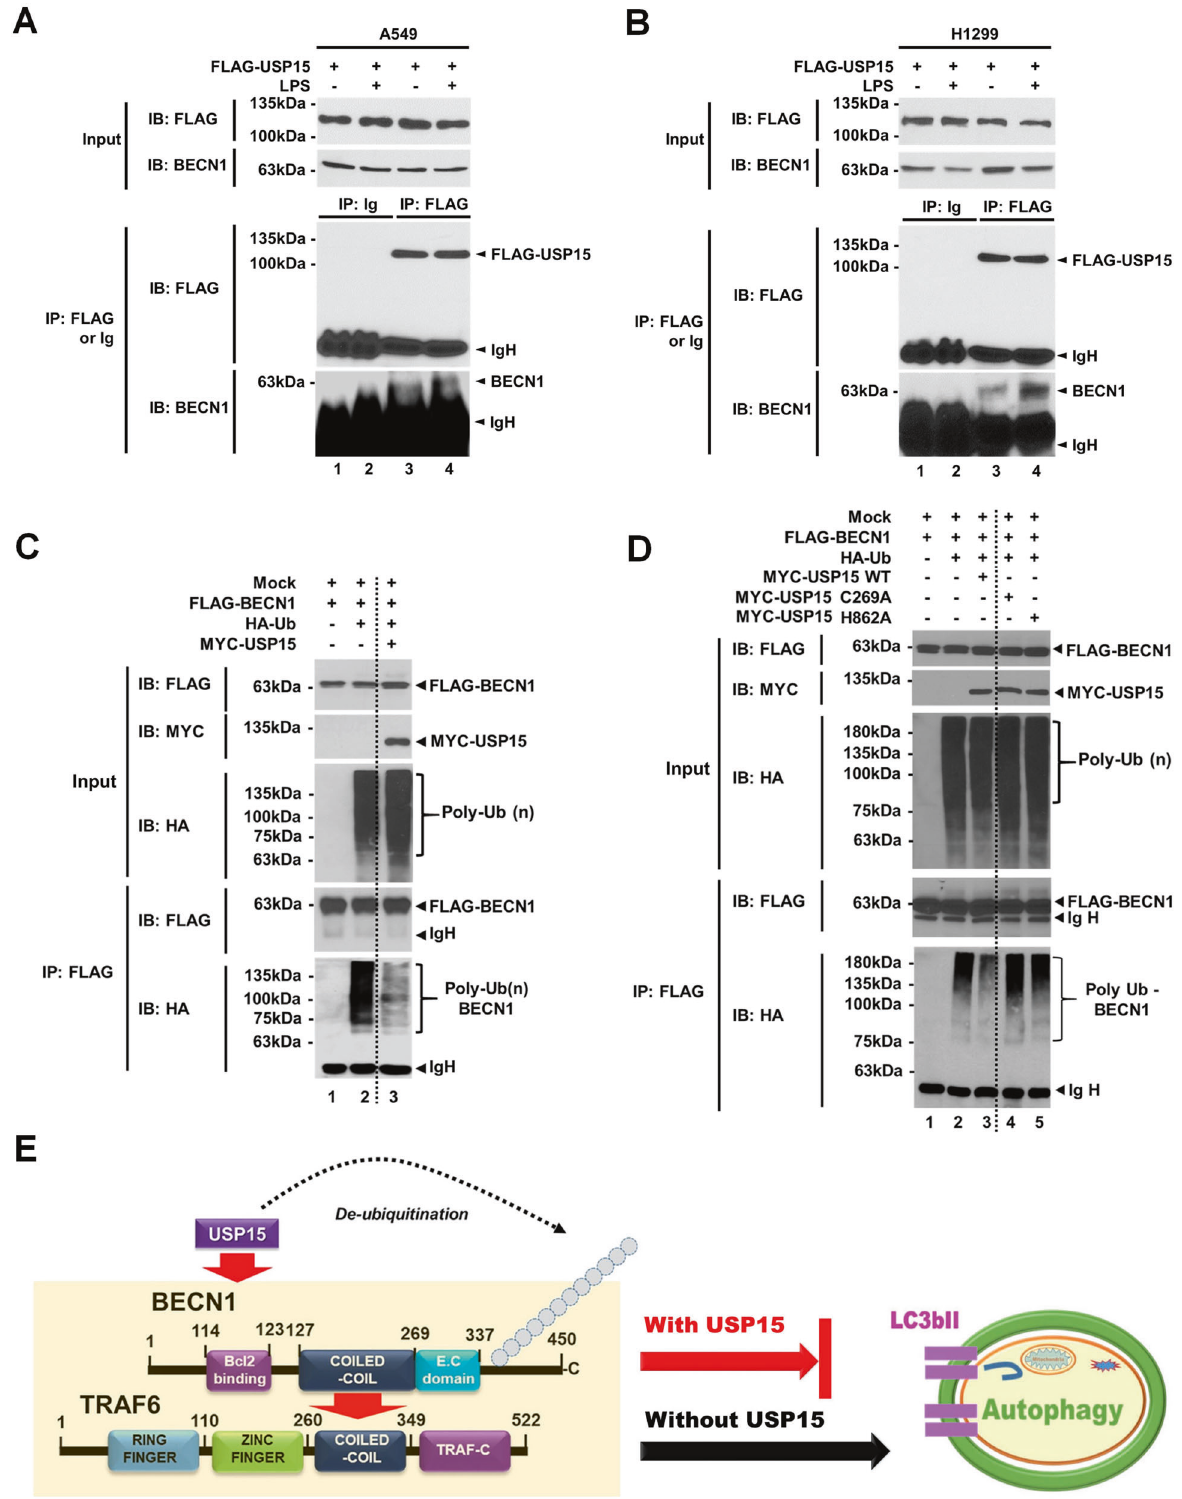
Fig. 7 USP15 induces deubiquitination of BECN1. A , B A549 ( A ) and H1299 ( B ) lung cancer cells were transiently transfected with FLAG- USP15. Immunoprecipitation (IP) assay was performed with anti-Ig or anti-FLAG antibodies, and then immune-probed with anti-FALG and anti- BECN1 antibodies, as indicated. C Immunoprecipitation (IP) assay was performed with anti-FLAG antibody using HEK 293T cells transfected with mock, FLAG-BECN1, HA-UB, and MYC-USP15 as indicated. Immunoblotting (IB) assay was performed with anti-FLAG or anti-HA antibody. D IP assay was performed with anti-FLAG antibody using HEK 293T cells transfected with mock, FLAG-BECN1, HA-Ub, MYC-USP15 wild-type (WT), MYC-USP15 C269A, and MYC-USP15 H862A as indicated. IB assay was performed with anti-FLAG or anti-HA antibody. E A schematic model of how USP15 induces deubiquitination of BECN1. In the presence of USP15, UPS15 interacts with BECN1 and induces deubiquitination of BECN1, leading to the inhibition of autophagy (indicated as a red arrow). In the absence of USP15, in contrast, TRAF6 interacts with BECN1 and induces ubiquitination of BECN1, leading to the induction of autophagy (indicated as a black arrow). Cell Death and Disease (2022)